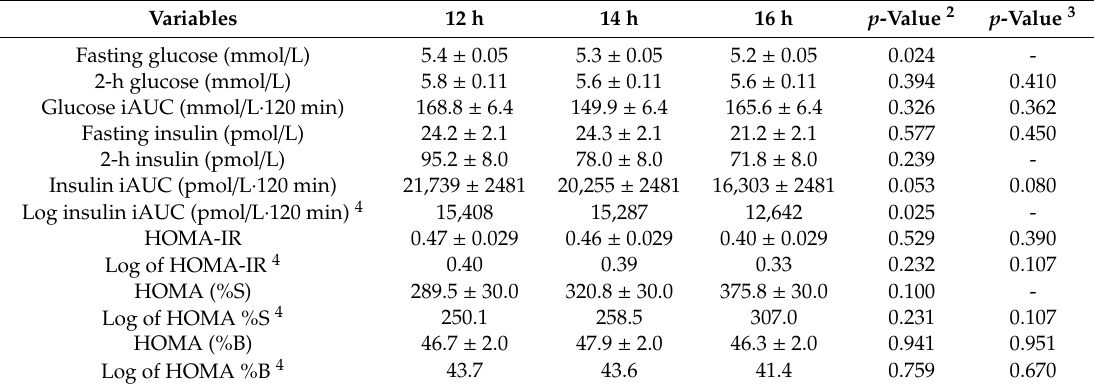
Table 2. Plasma glucose and insulin responses for the three overnight fasting periods in males. 1.